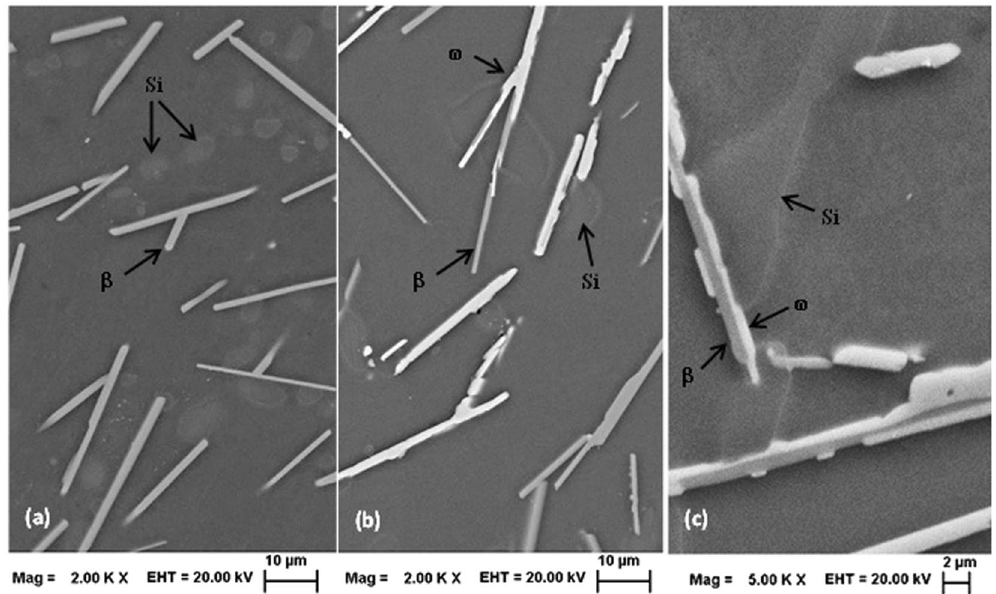
Figure 3. BSE image of the samples solutionized at 793 K for 86.4 ks; ( a ) 2Cu sample showing needle like β -Al 9 Fe 2 Si 2 phase and Si (arrow) ( b ) 4Cu and ( c ) 6Cu sample showing with remaining β -Al 9 Fe 2 Si 2 phase (arrows); atomic number contrast is apparent between these two phases. The θ -Al 2 Cu phase was absent in all solutionized